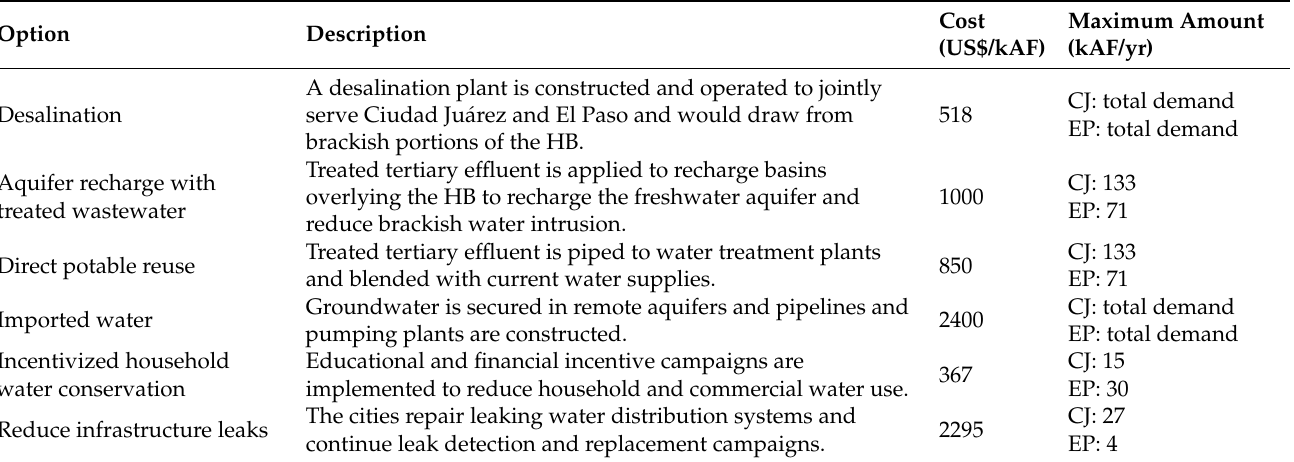
Table 4. Options for offsetting pumping